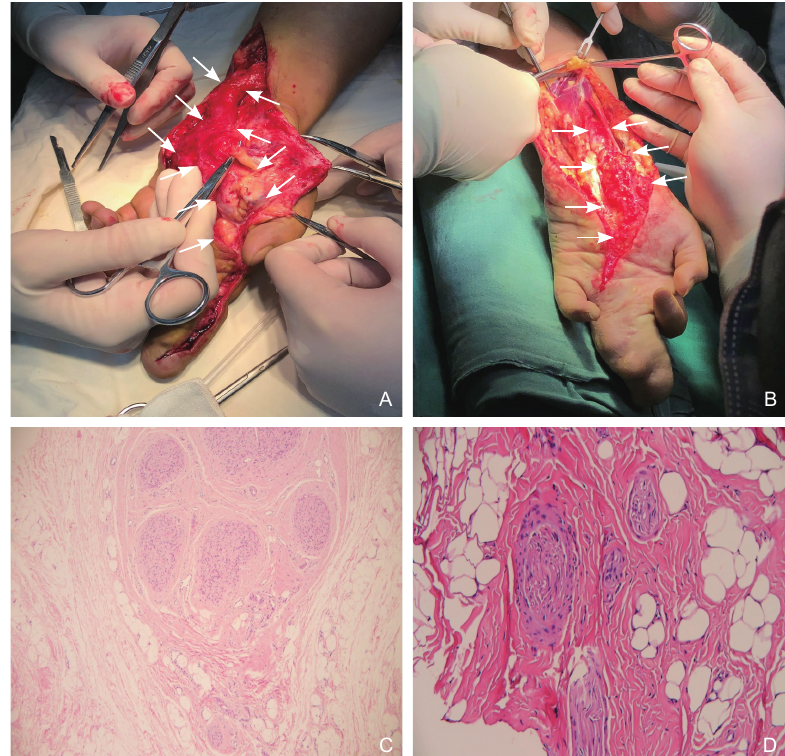
A B Figure 2 (A-B) Intraoperative photograph of lipomatosis of the median nerve, showing the obvious enlargement of the affected nerve (arrow); (C-D) Histopathologic image of lipomatosis of nerve, showing the infiltration of the perineurium of the nerve by mature fibrous and adipose tissue (hematoxylin and eosin staining; magnification, × 200).